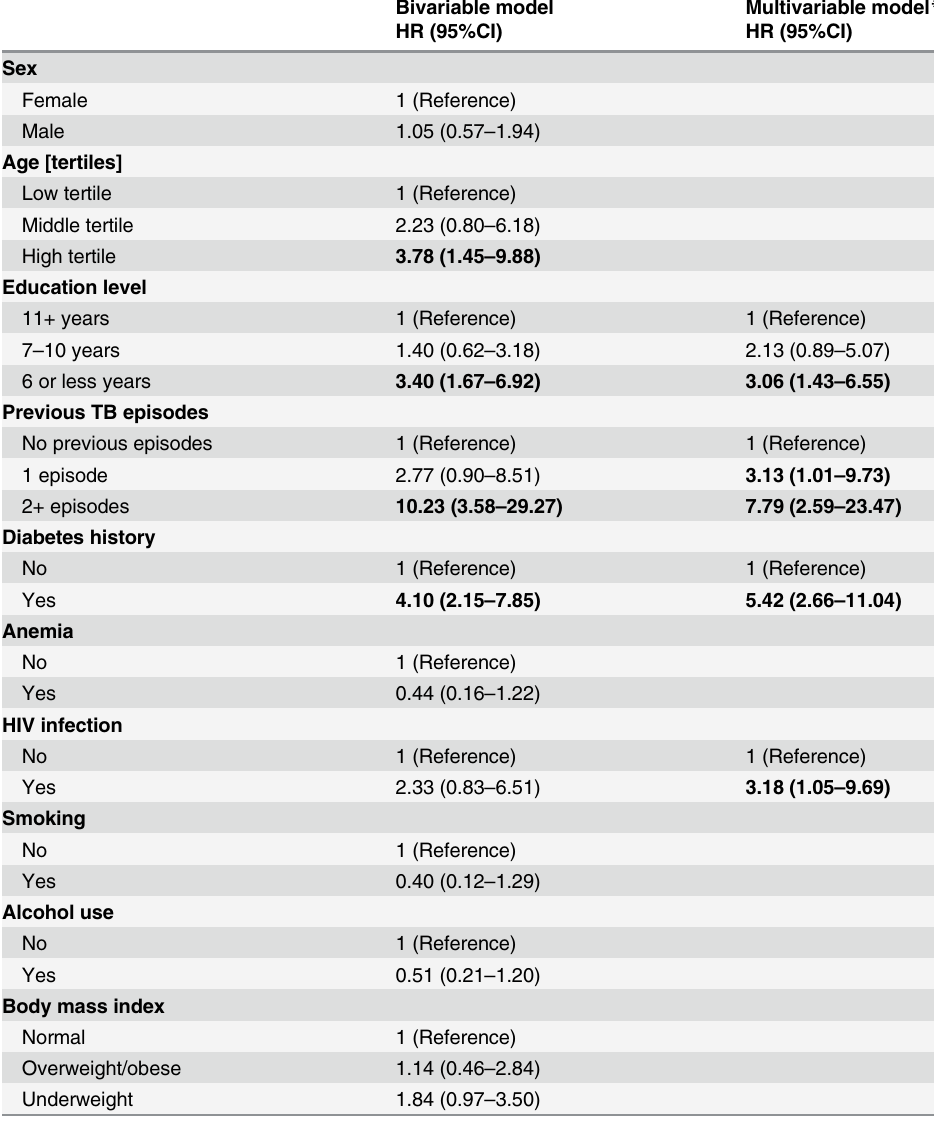
Table 3. Factors independently associated with mortality among MDR-TB